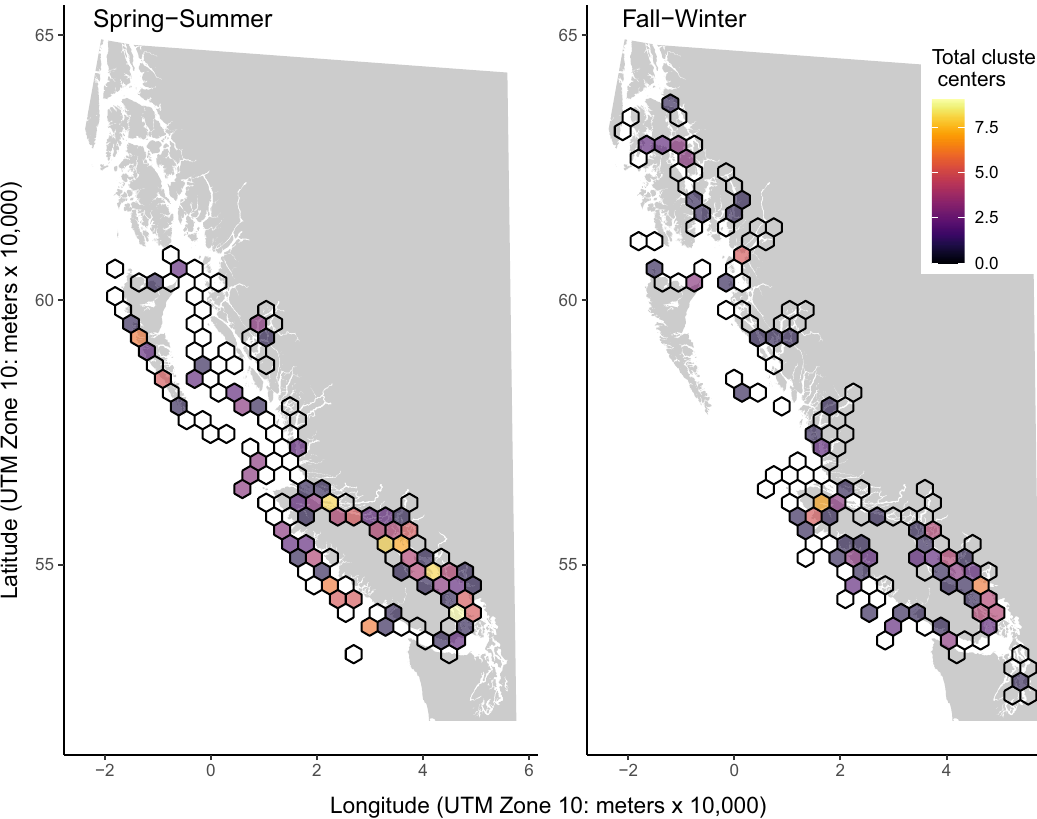
Figure 3. The total number of statistically significant positive prevalence cluster centers per 30 km hexagon. Empty cells indicate that samples were collected in these locations but no clusters were centered there. An interactive map that identifies pathogen and host species identities for clusters in each hexagon is available in Supplementary Material